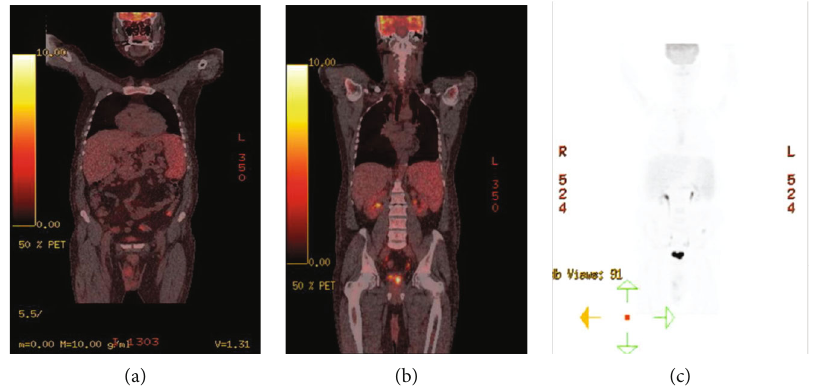
Figure 1: PET-CT scan. Initial PET-CT. (a) Shows the hypermetabolic lesions, which can be seen in the descending colon, and the augmented signaling of the liver without renal compromise is documented. (b, c) PET-CT scans showing nonenhancement of the kidney